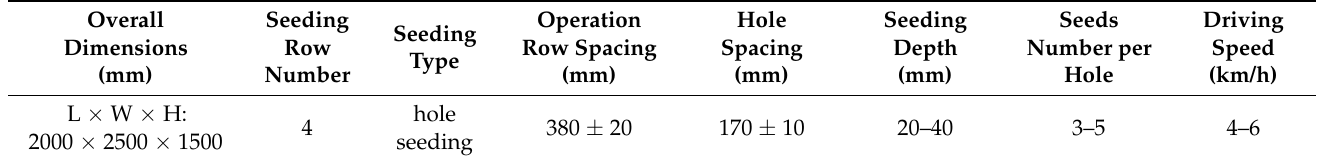
Table 1. Main technical parameters of buckwheat hill-drop planter.